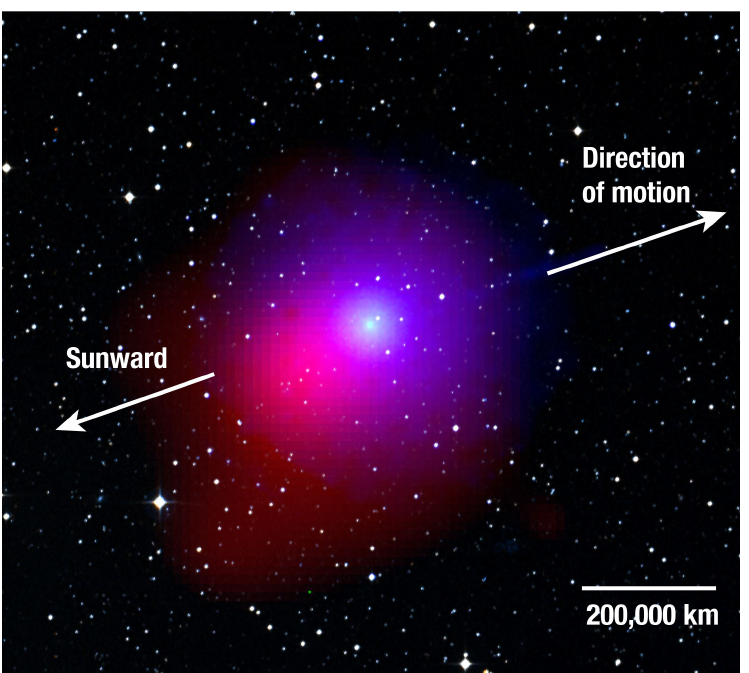
Figure 9. Combined Swift -UVOT and X-ray Telescope observations of comet C/2007 N3 (Lulin). This bright comet allowed UVOT to image the cloud of OH radicals in its coma (blue) and XRT to detect X-rays produced by solar wind charge exchange (red). Because of the comet’s large gas production rates, the coma is collisionally thick to charge exchange and is thus offset towards the direction of the Sun (after